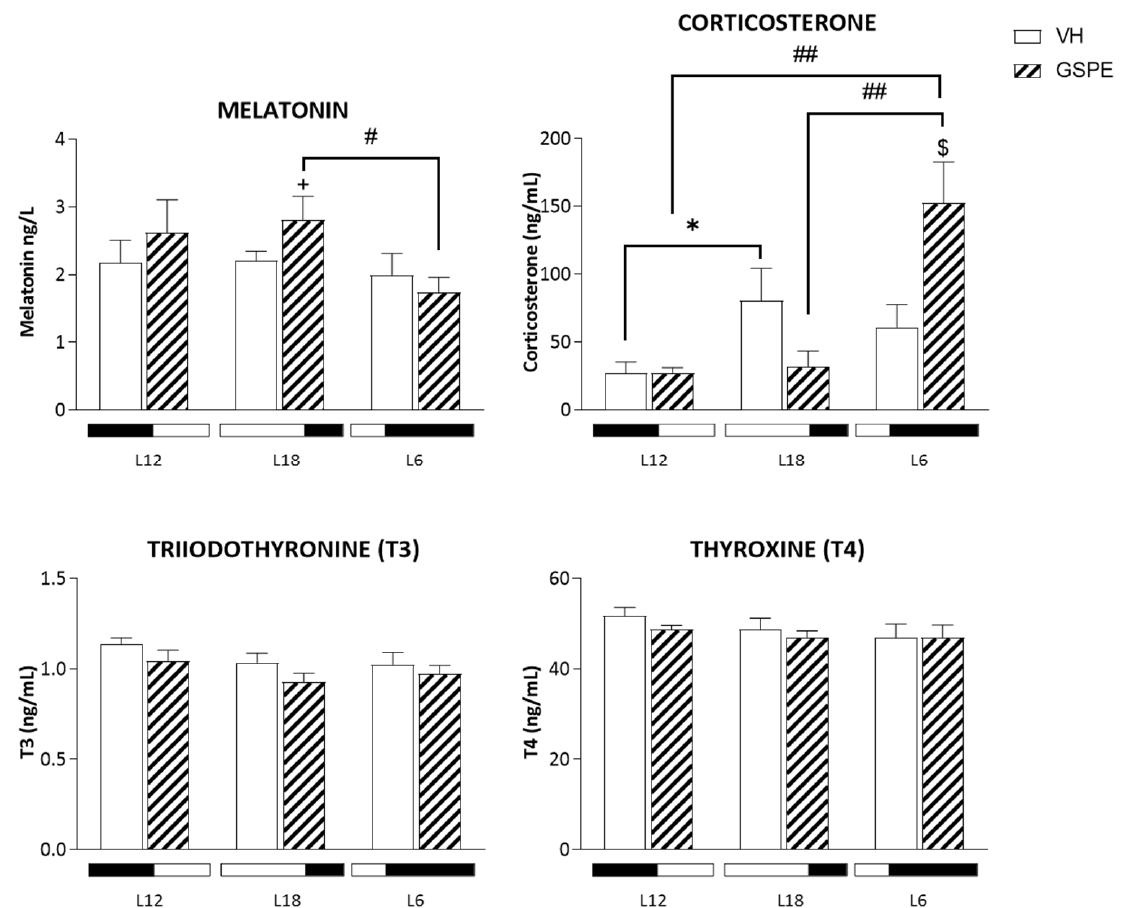
Figure 3. Concentration of serum hormones in response to different photoperiod exposure and GSPE treatment in animals fed a STD for 9 weeks. Fischer 344 rats fed a STD diet were treated with VH or GSPE and exposed to standard (12 h light:12 h dark), long (18 h light:6 h dark), or short (6 h light:18 h dark) photoperiods ( n = 8). The results are presented as the mean ± SEM. * indicates significant differences within VH groups (Student’s t test, * p < 0.05); # indicates significant differences within GSPE groups (Student’s t test, # p < 0.05, ## p < 0.01); $ indicates significant differences between treatments (VH vs. GSPE) (Student’s t test, $ p < 0.05). + indicates tendency between VH and GSPE treatment in L18 using Student’s t test (+ p = 0.050).